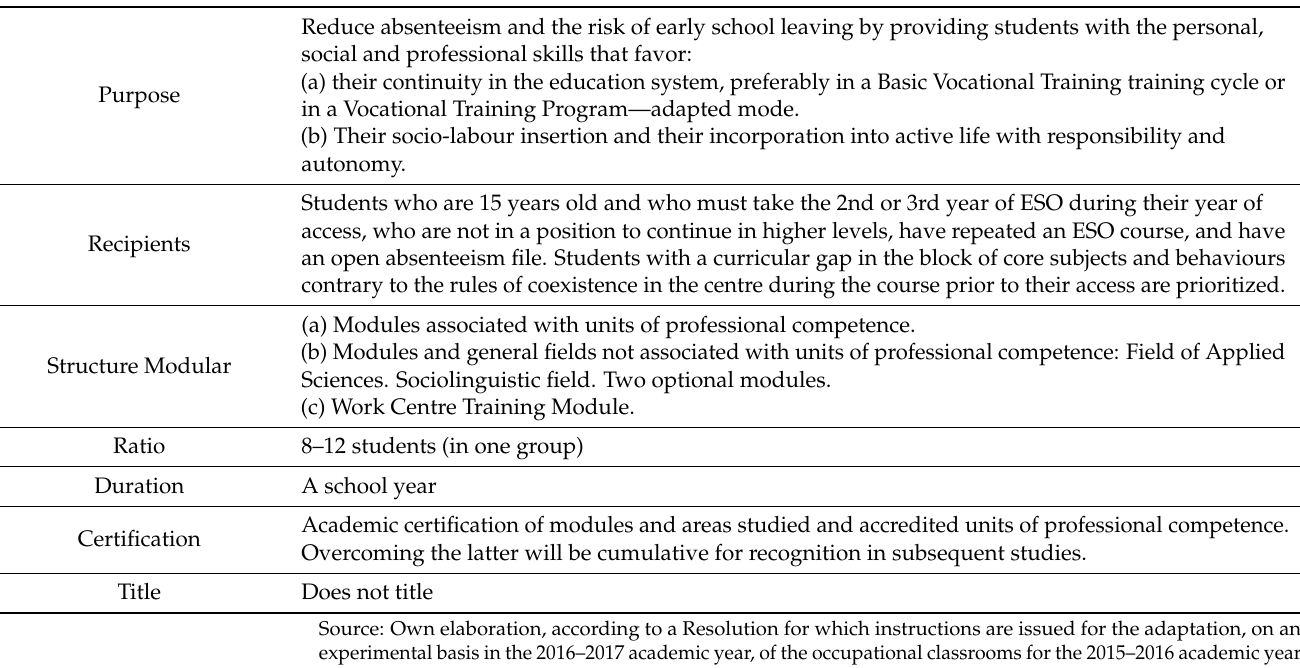
Table 3. Purpose and main characteristics of the Occupational Classrooms in the Region of